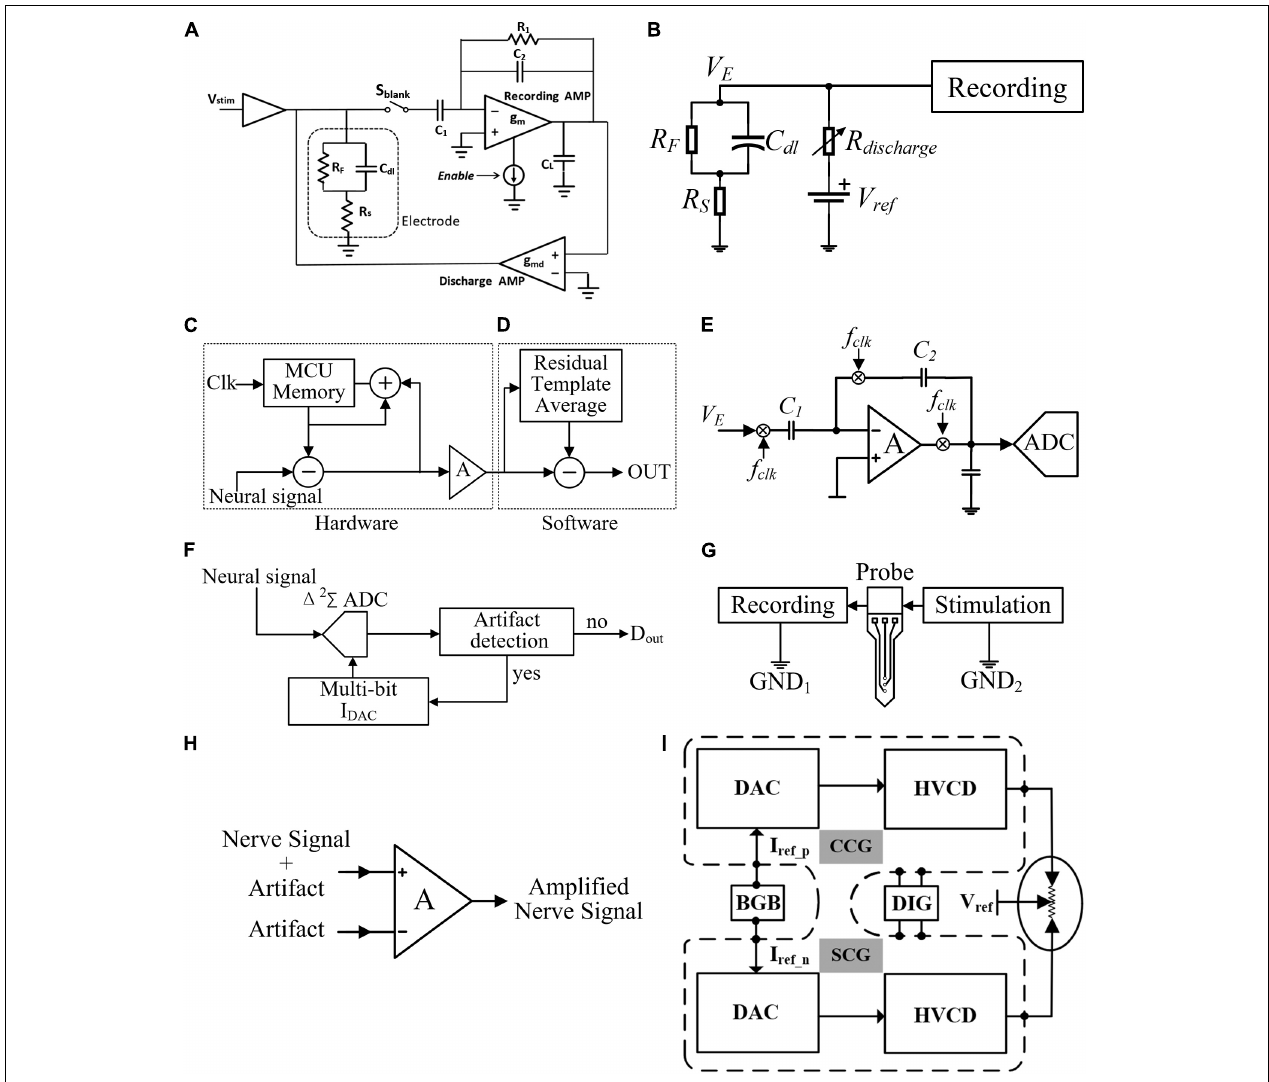
FIGURE 4 | (A) Artifact elimination circuit with blanking technique, (B) active electrode discharge technique, (C) iterative hardware loops, (D) adaptive filtering technique in post-processing, (E) chopper technique, (F) track-and-zoom (TAZ) neural ADC, (G) localized stimulation technique, (H) dual electrode in-phase stimulation, and (I) RTPPS